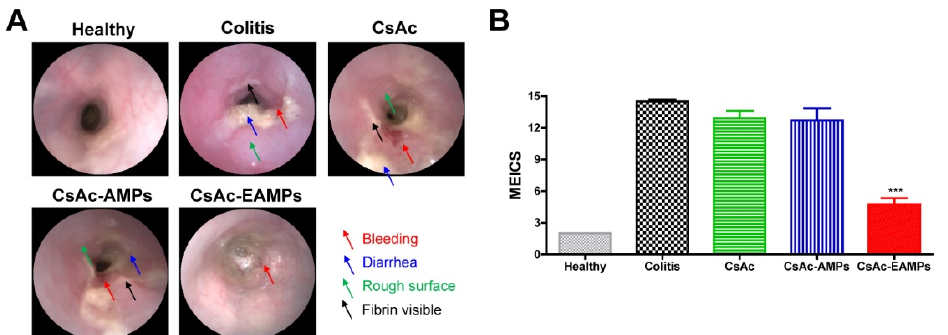
Figure 4. Endoscopic examination of the colon on day 14. ( A ) Representative endoscopic images ( B ) Murine endoscopic index of colitis severity (MEICS) scores. *** denotes p < 0.001 compared with the untreated colitis group. The results are expressed as means ± standard deviation ( n = 8). CsAc, cyclosporine A crystals; CsAc-AMPs, CsA crystal-loaded alginate microparticles; CsAc-EAMPs, CsA crystal-loaded, Eudragit S 100 coated alginate microparticles.